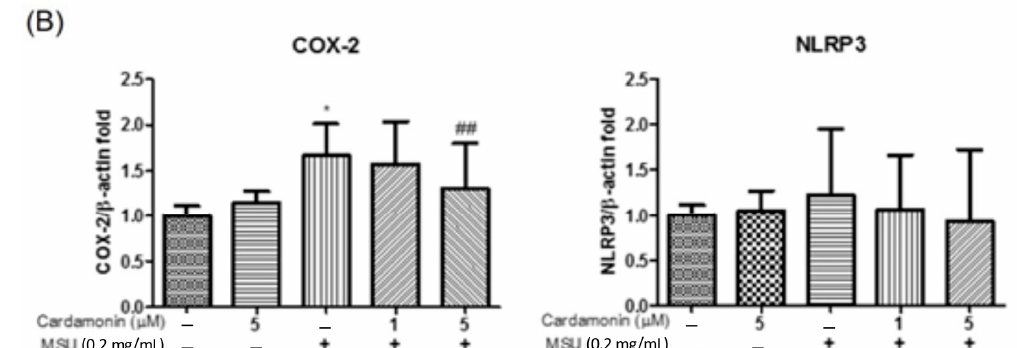
Figure 3. Effects of cardamonin on MSU-stimulated NLRP3 inflammasome activation in J774A.1 macrophage cells. ( A ) Levels of COX-2 and NLRP3 expression in cell lysates. ( B ) Western blot analysis results aimed at detecting the levels of NLRP3 and caspase-1 in cell lysates. (–) not treatment; (+) treatment. Each value represents the mean ± SD. Statistical differences among the MSU groups were compared against the control values, whereas the cardamonin groups were compared against the MSU group using the ANOVA test ( n = 5; * p < 0.05 vs. control; ## p < 0.01 vs. MSU).